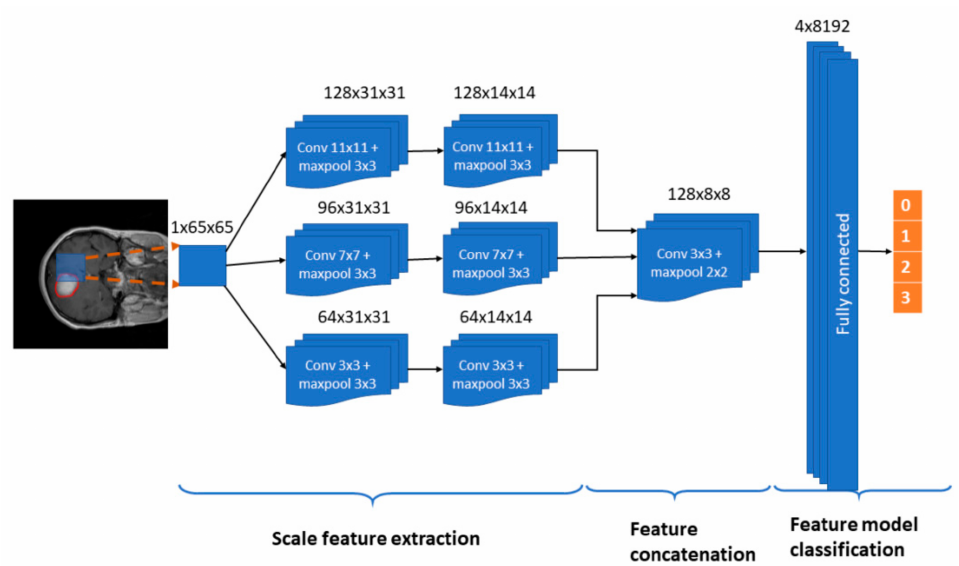
Figure 2. The proposed Convolutional Neural Networks (CNN) architecture. Input: 1 × 65 × 65 slid- ing windows. Model: Three pathways (large, medium, and small feature scales) with 2 convolutional layers and max-pooling, a convolutional layer with concatenation of the three pathways, and a fully connected stage that leads to a classification in one out of the four possible output labels: 0—healthy region, 1—meningioma tumor, 2—glioma tumor, and 3—pituitary tumor. A dropout mechanism between the concatenation and fully connected stages is